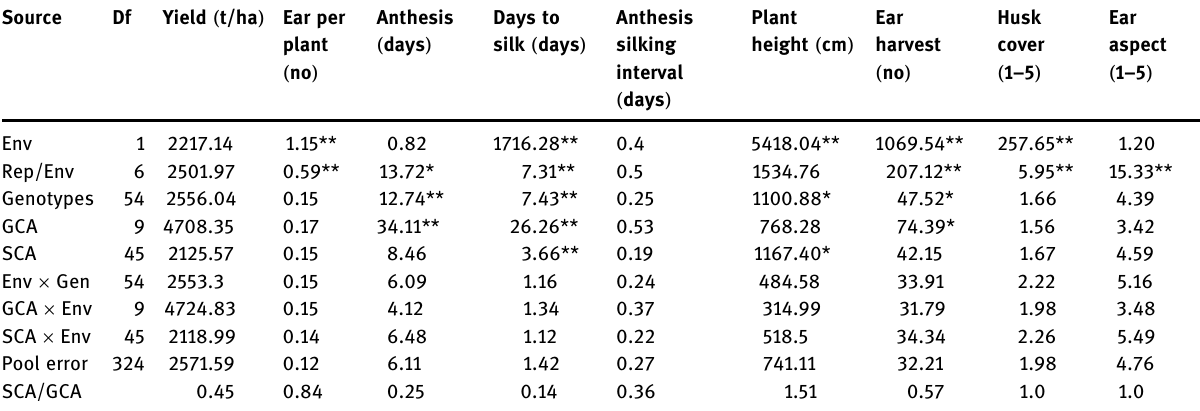
Table 1: ANOVA of combining ability for grain yield and agronomy traits in F 1 hybrids and parents across stress - free condition ( Ikenne and Ife 2012 )